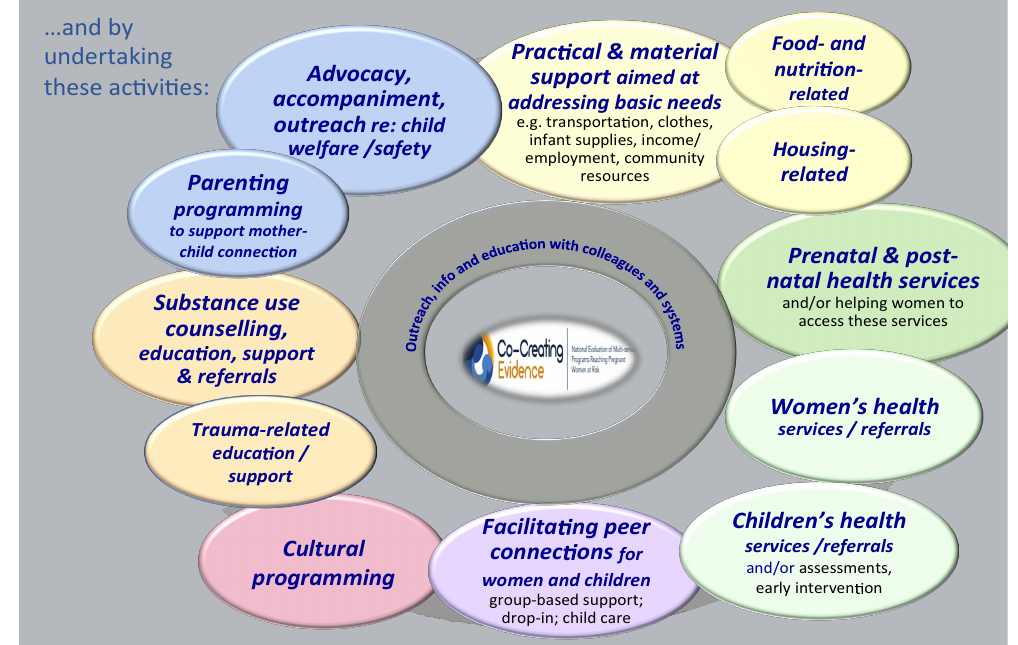
Figure 3. Key activities/services of programs involved in the Co-Creating Evidence project.